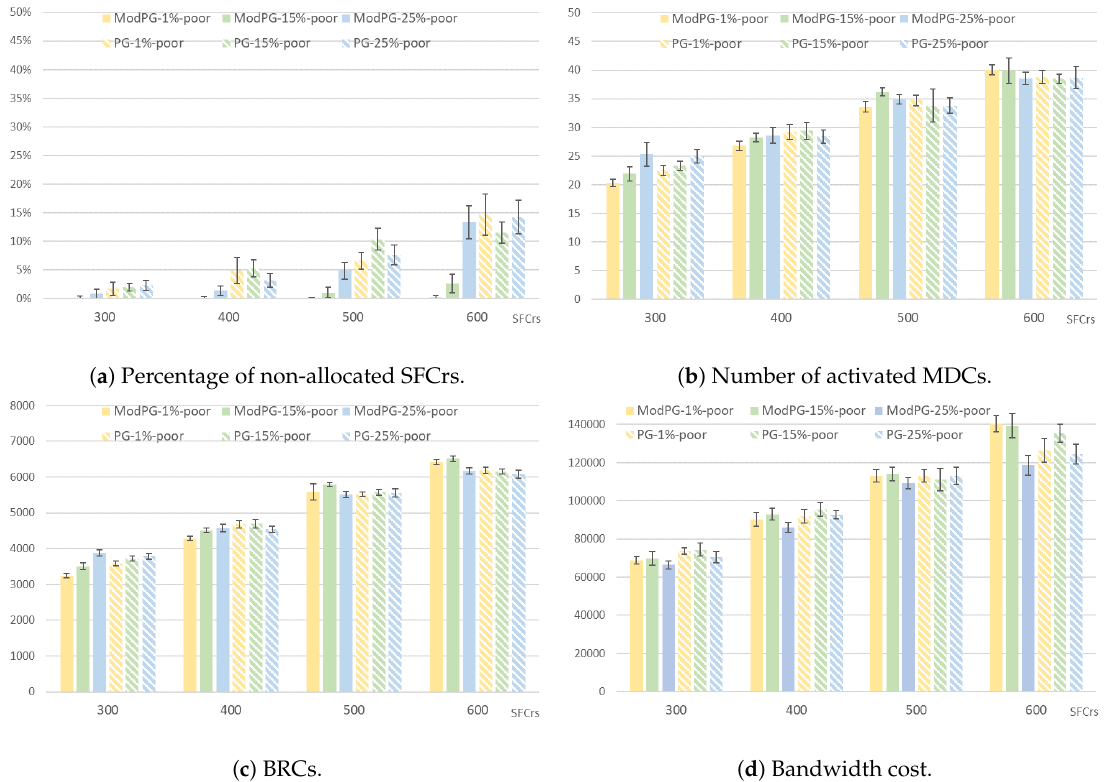
Figure 4. Scenario 2: CPU and memory capacity of MDCs set to